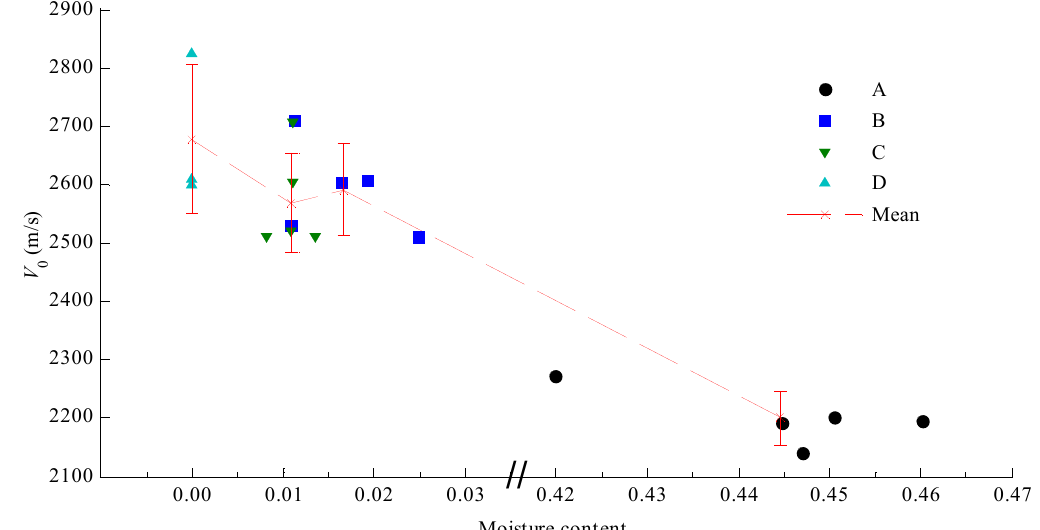
Figure 4. Initial wave speed of specimens.